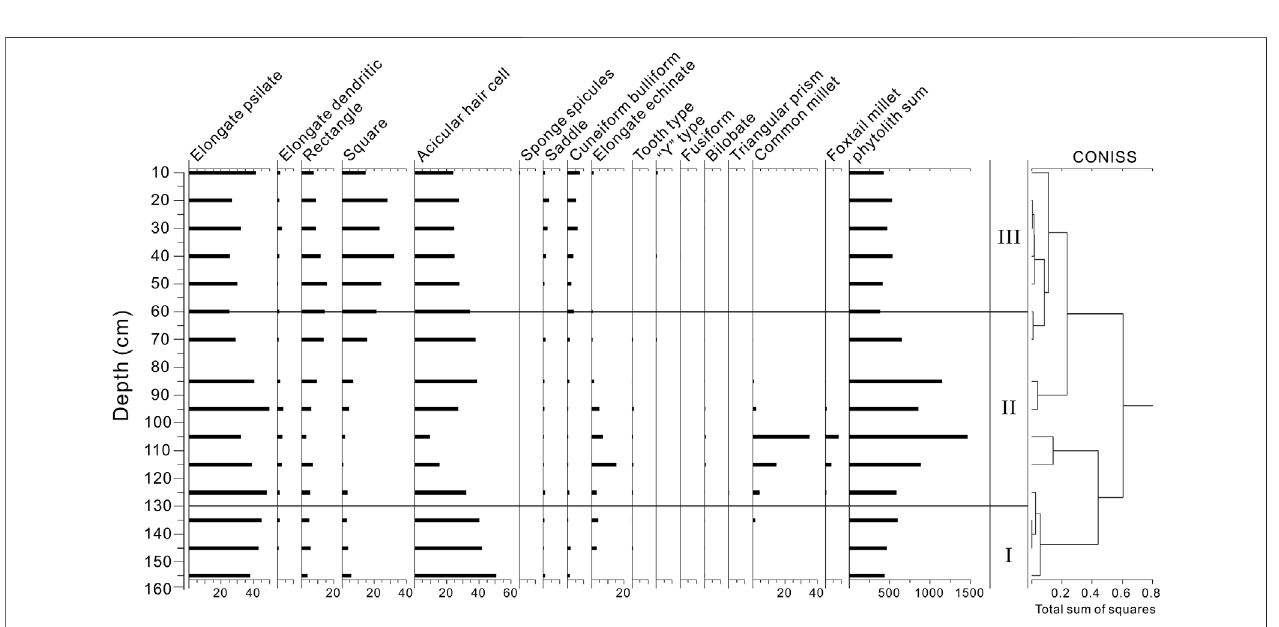
Frontiers in Earth Science |